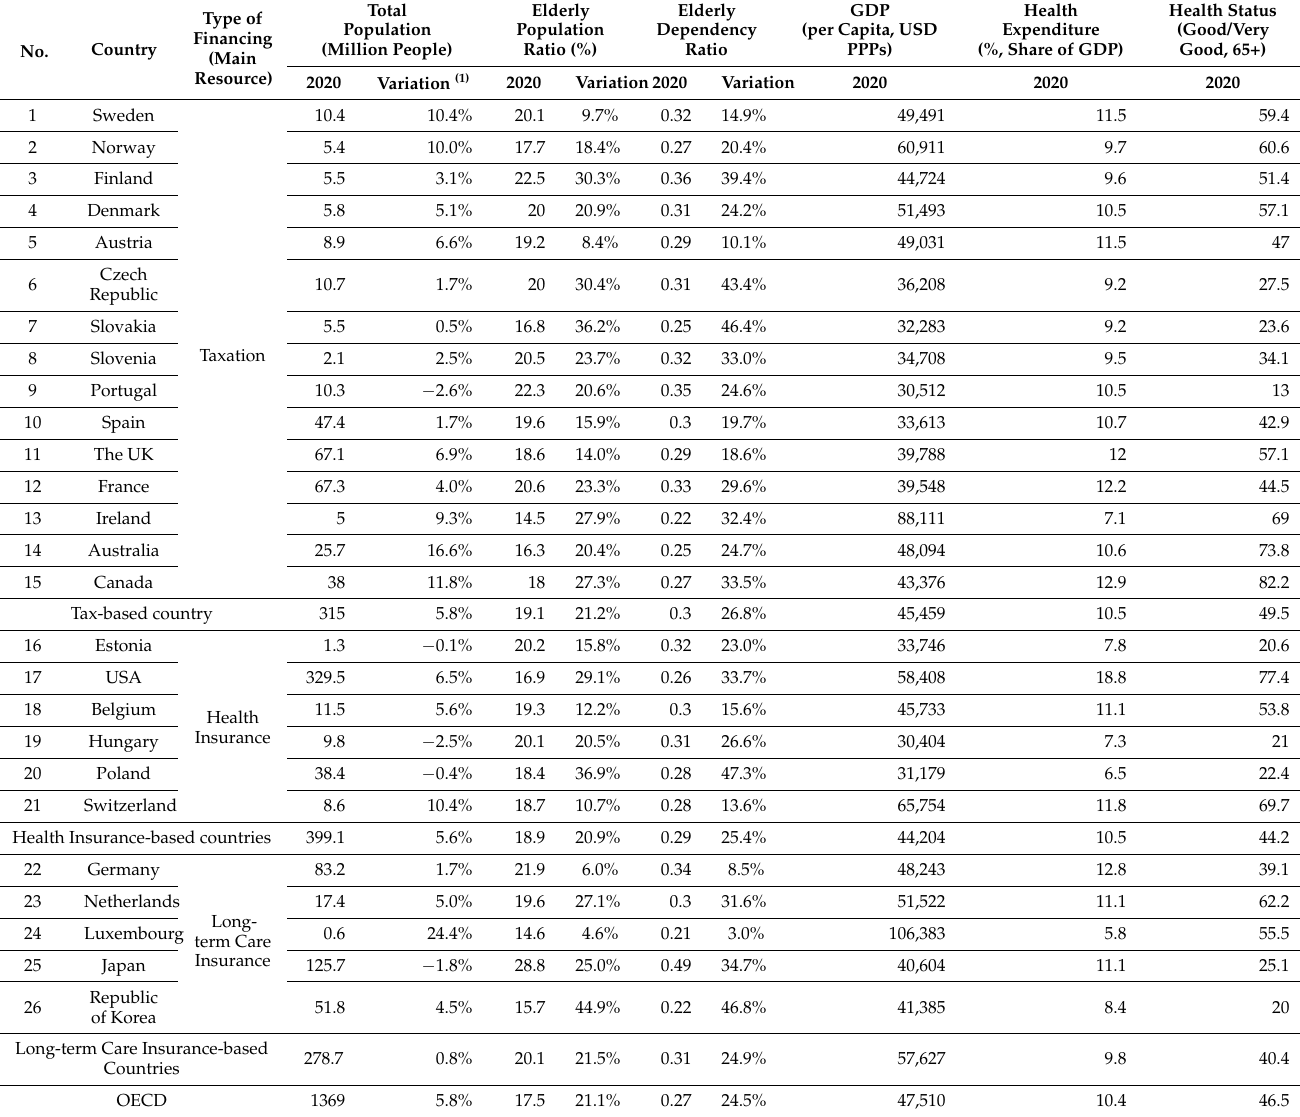
Table 2. Analysis of long-term care financing types by OECD country (as of 2020)